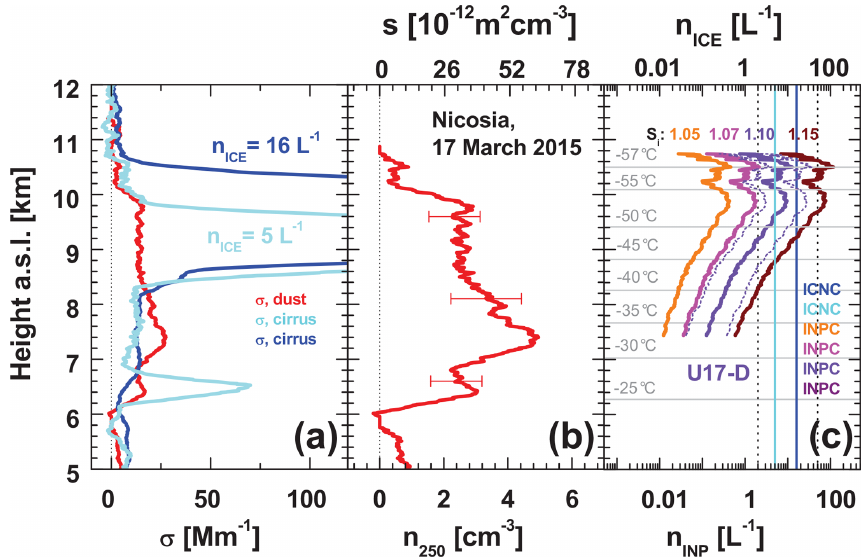
Figure 13. Same as Fig. 9 except for a cirrus layer observed with lidar over Nicosia on 17 March 2015 (see Fig. 5e and f) during the Cyprus- 2015 campaign. (a) Dust extinction coefficient (red, 23:05–23:30UTC mean), ice crystal extinction coefficient (blue, 20:00–20:40UTC mean, cirrus from 8.6 to 10.6km; light blue, 22:15–22:19UTC mean, cirrus from 8.4 to 9.8km), and estimated ICNC ( n ICE for the 20:00– 20:40 and 22:15–22:19UTC periods); (b) dust particle number concentration n 250 , d and surface area concentration s d (23:05–23:30UTC mean values); (c) INPC ( n INP , 23:05–23:30UTC mean) by using the U17-D(d) parameterizations for four different ice supersaturation values ( S i from 1.05 to 1.15). The uncertainty range of each of the four profiles is indicated for S i = 1 . 10 (violet thin dotted lines). The ICNC values (numbers in a ) are shown as vertical light-blue and dark-blue lines with the overall uncertainty range as vertical black dashed